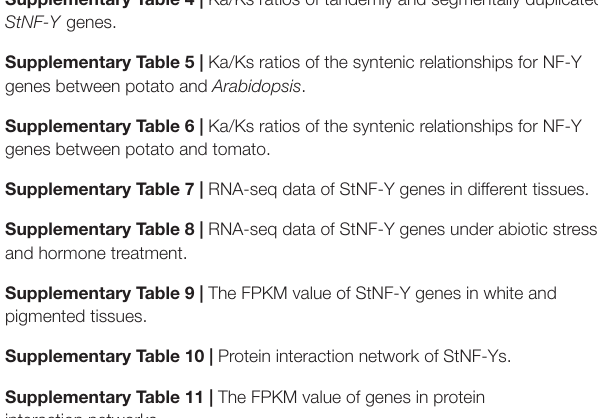
Supplementary Table 3 | Conserved motifs identified by MEME among StNF-Ys.